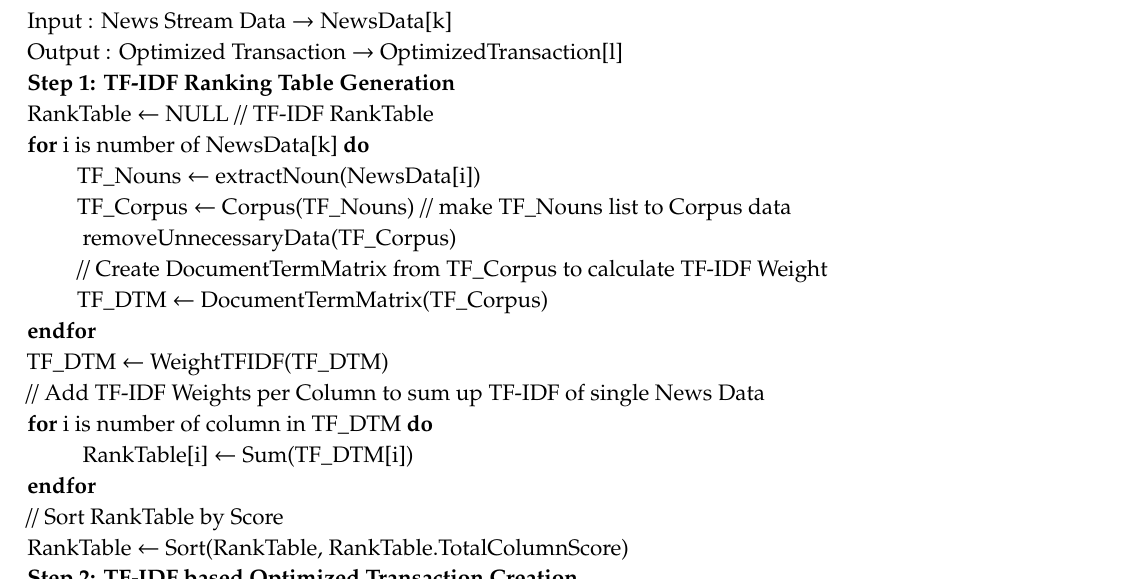
Algorithm 1 Optimized Transaction Generation